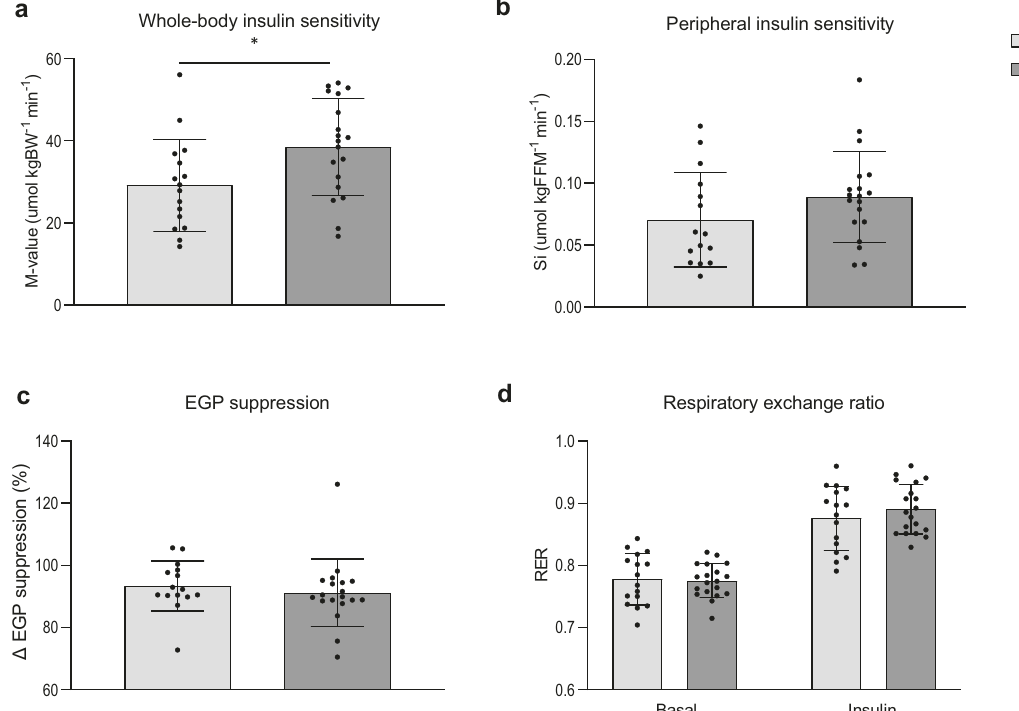
Fig. 5 Effect of exercise training on insulin sensitivity and substrate selection in older adults. a Whole-body insulin sensitivity based on the M -value measured during a hyperinsulinemic-euglycemic clamp. b Insulin-stimulated glucose uptake corrected for plasma insulin and glucose levels (S i ) and expressed per kg FFM c EGP suppression, calculated as the percentage insulin-suppressed EGP from the basal EGP. d Respiratory exchange ratio measured before, in resting conditions (Basal), and during insulin stimulation (Insulin). Light gray bars represent normally active older adults (O, n = 15); dark gray bars represent trained older adults (TO, n = 19). Because only 3 IO participants could undergo the clamp, these results were not considered. One O participant was excluded for analysis due to violation of the protocol instructions. For one O participant tracer data could not be analyzed. Values are presented as mean ± SD (with individual data points), asterisk denotes signi fi cant differences between the two groups ( p < 0.05 two-sided, independent samples t -test). M -value mean glucose infusion rate, BW body weight, S i insulin-stimulated glucose disposal, FFM fat-free mass, EGP endogenous glucose